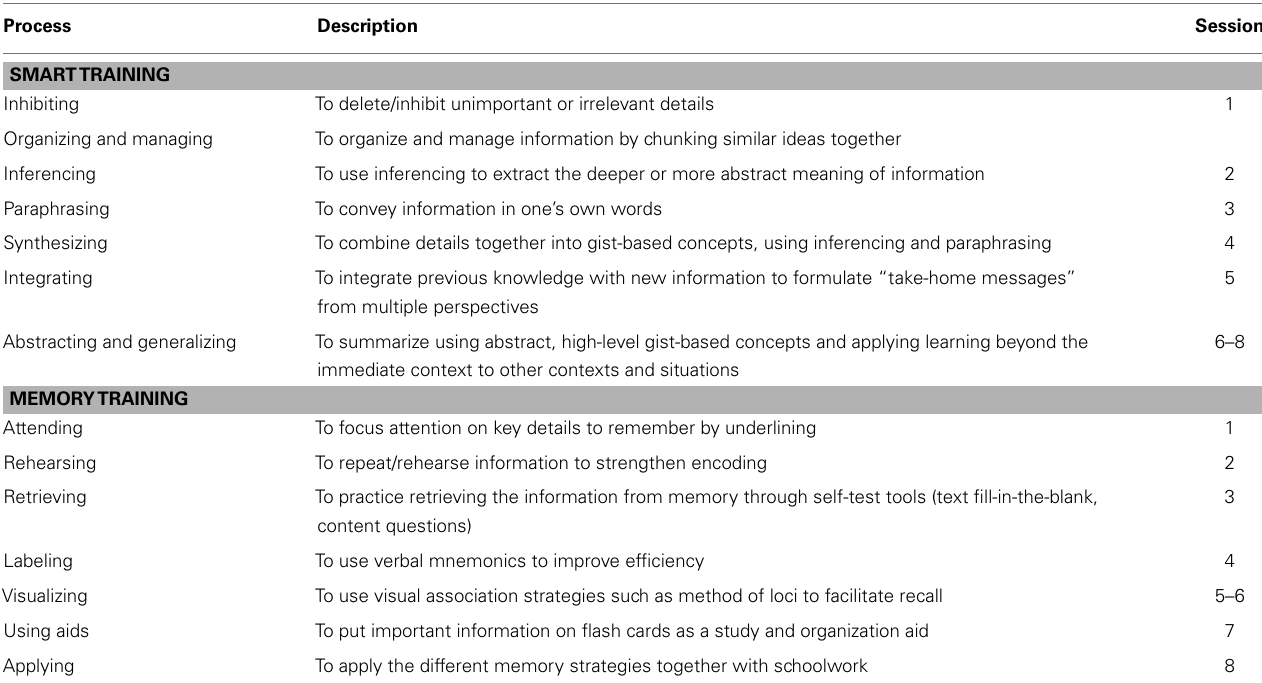
Table 2 | Outline of SMART and memory trainings